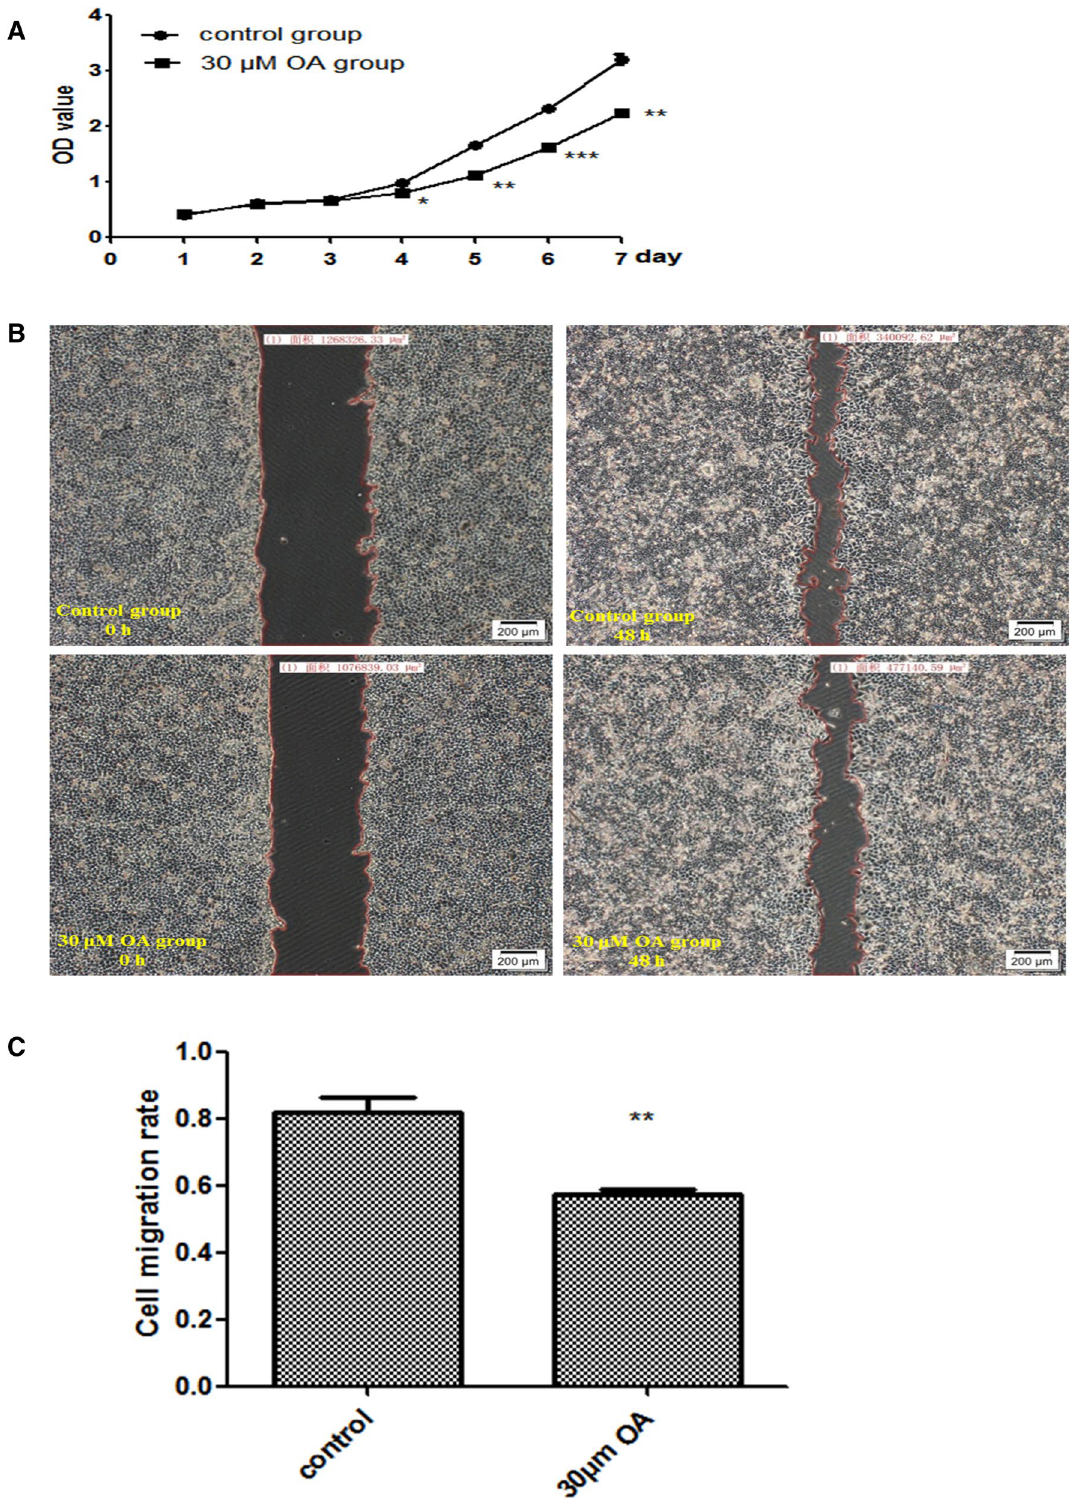
Figure 5. ( A ) Proliferation of Hep-2 cells following treatment with oleanolic acid (OA). * P < 0.05, ** P < 0.01, *** P < 0.001, compared with the control group. ( B ) Changes in the migration of Hep-2 cells following treatment with oleanolic acid (40 ×). Upper left panel, Control group 0 h; upper right panel., Control group 48 h; bottom left panel, 30 μM OA group 0 h; bottom right panel, 0 μM OA group 48 h. ( C ) Quantification of the migration of Hep-2 cells following treatment with OA. ** P < 0.01, compared with the control